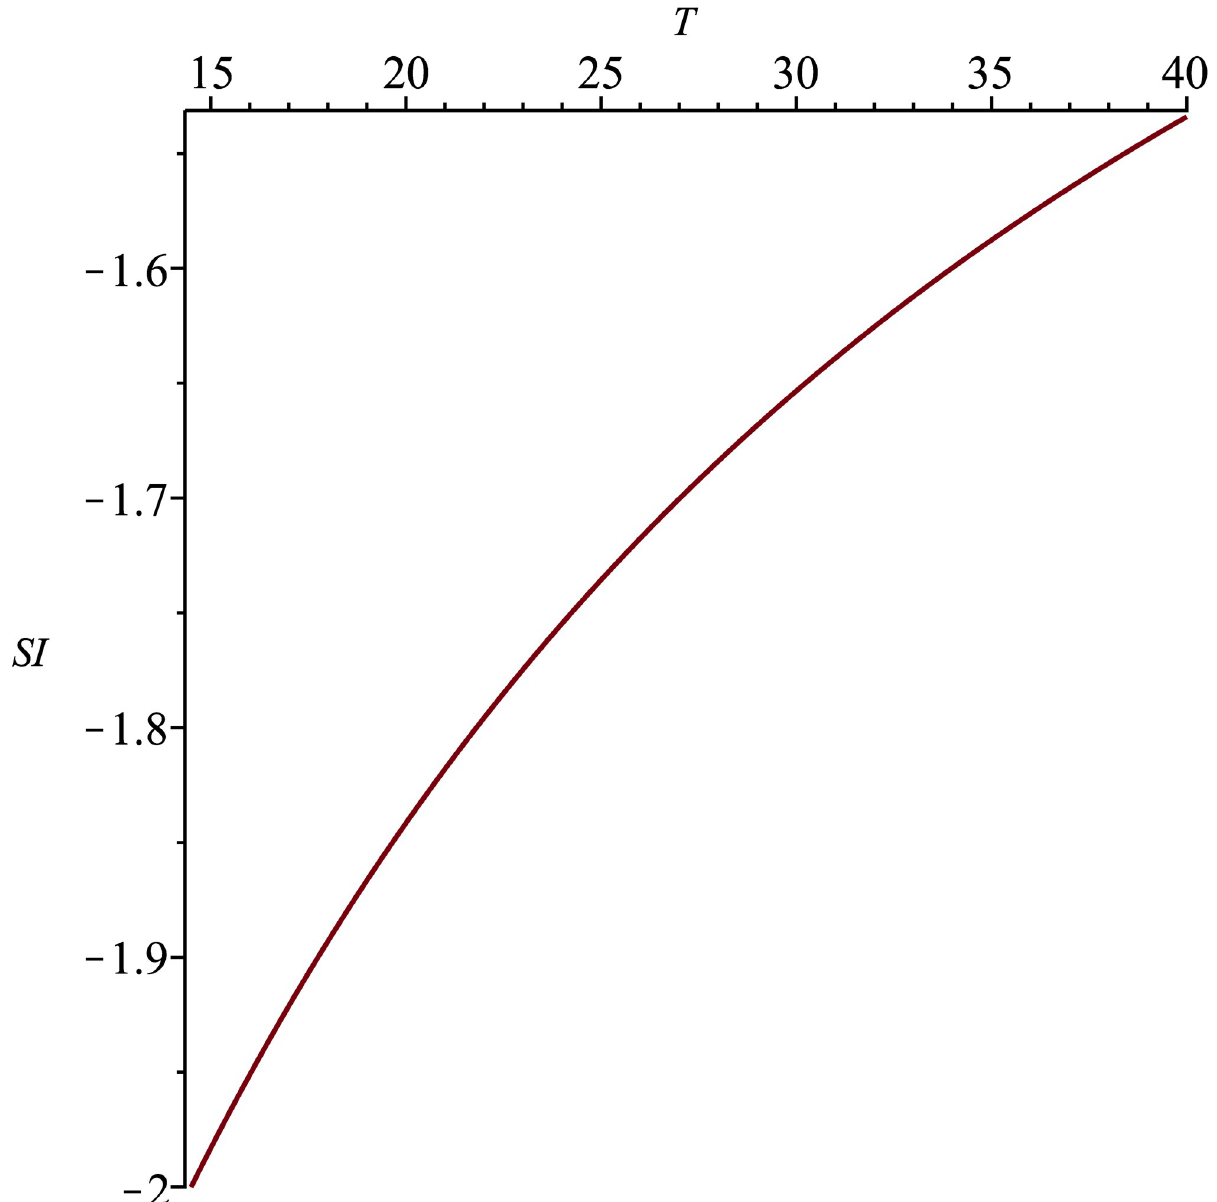
Fig 3. Sensitivity index Ω R 0